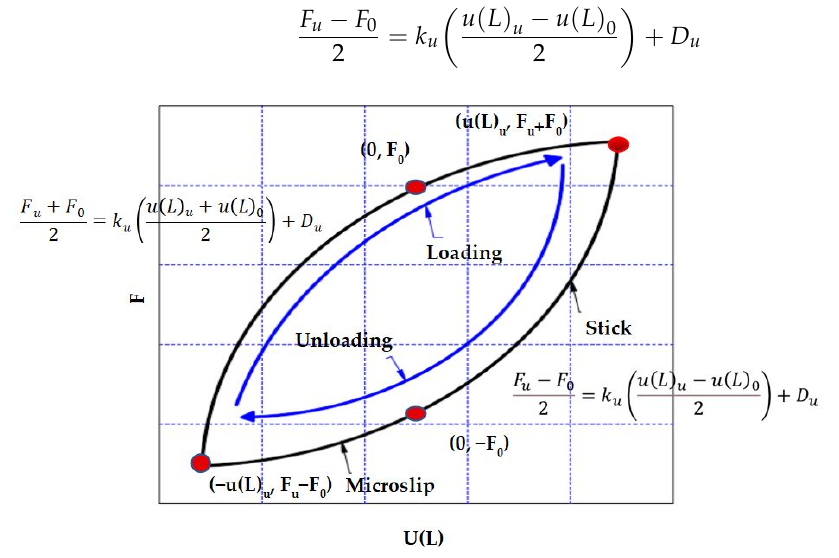
Figure 6. Force–displacement hysteresis curve.